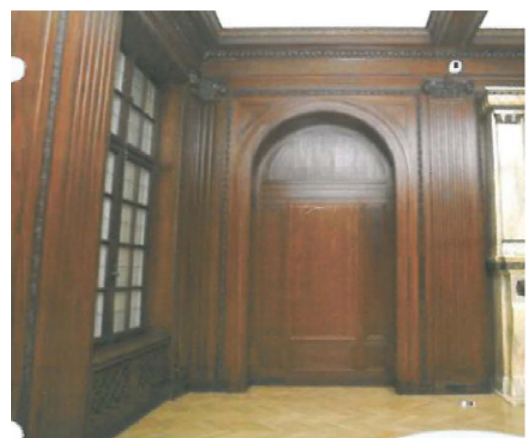
Picture 7: Original sketch of pass points for undistortion of pictures